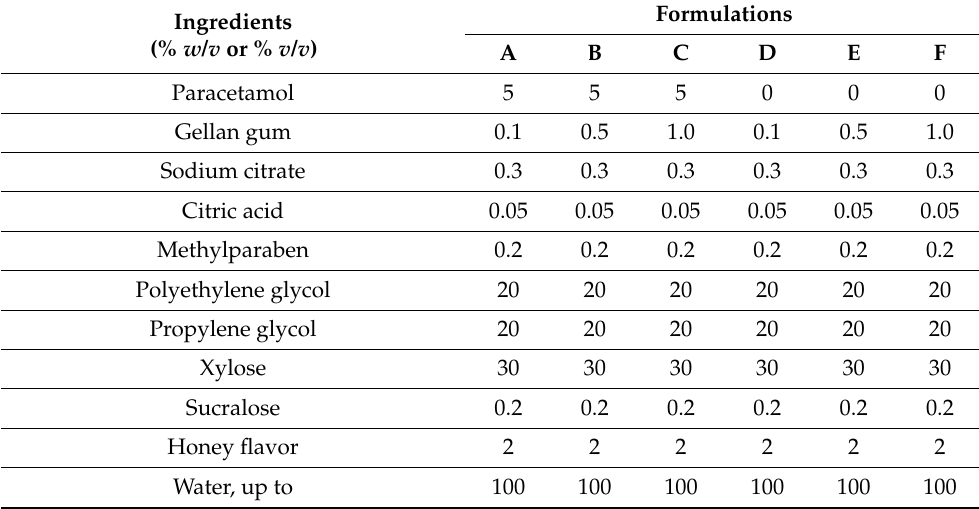
Table 4. Formulations of fluid gel